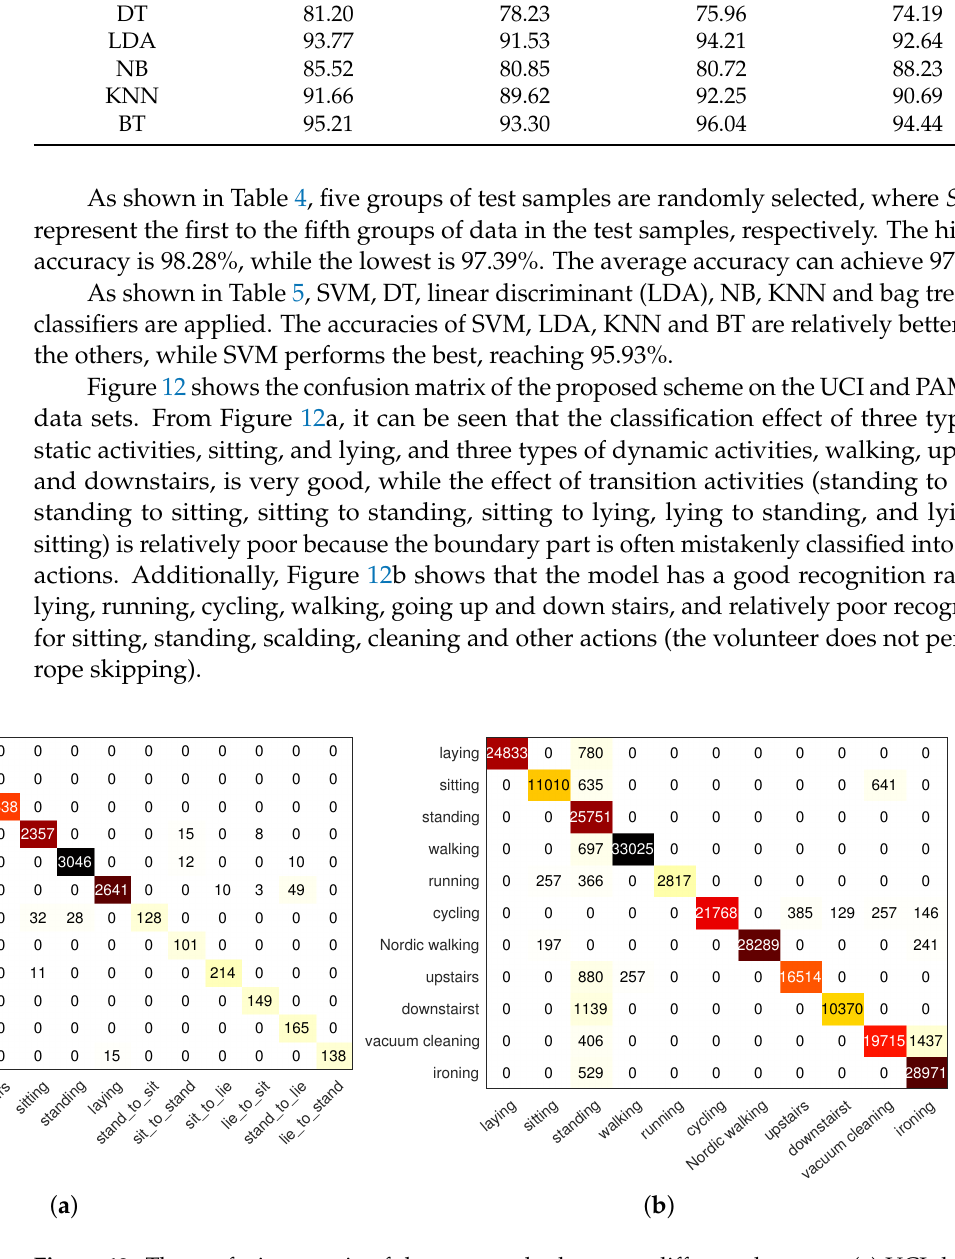
Figure 12. The confusion matrix of the proposed scheme on different data sets. ( a ) UCI data set, and ( b ) PAMAP2 data